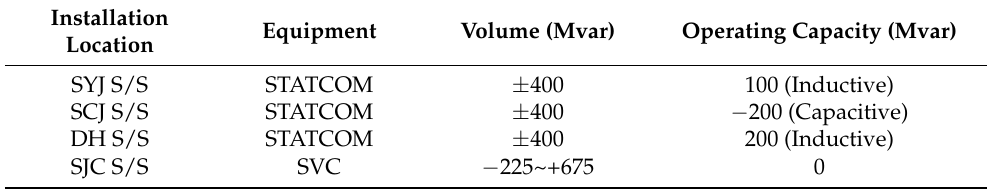
Table 2. FACTS installation and operation status near TCSC.